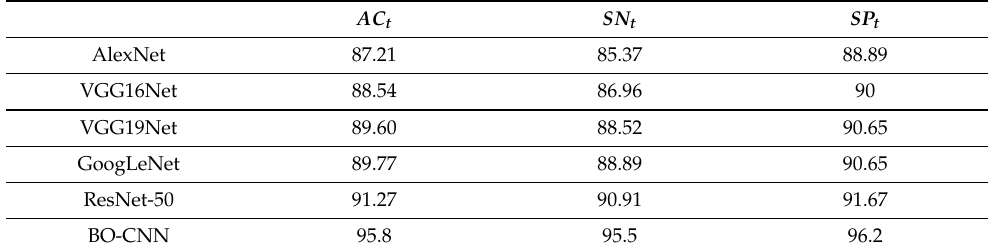
Table 7. Proposed BO-CNN model vs. pre-trained-CNN models for the OCT dataset.